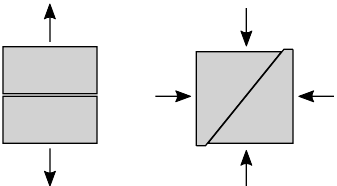
Figure 1. Schematic illustration of two characteristic failure modes (according to [23]): tensile failure (opening mode, left ) and shear failure (sliding mode, right